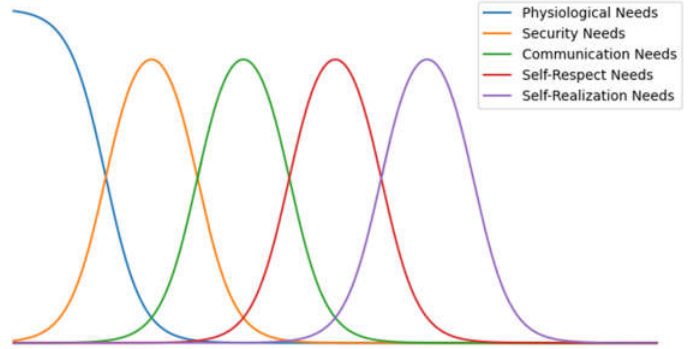
Figure 2. Needs level development relationship.